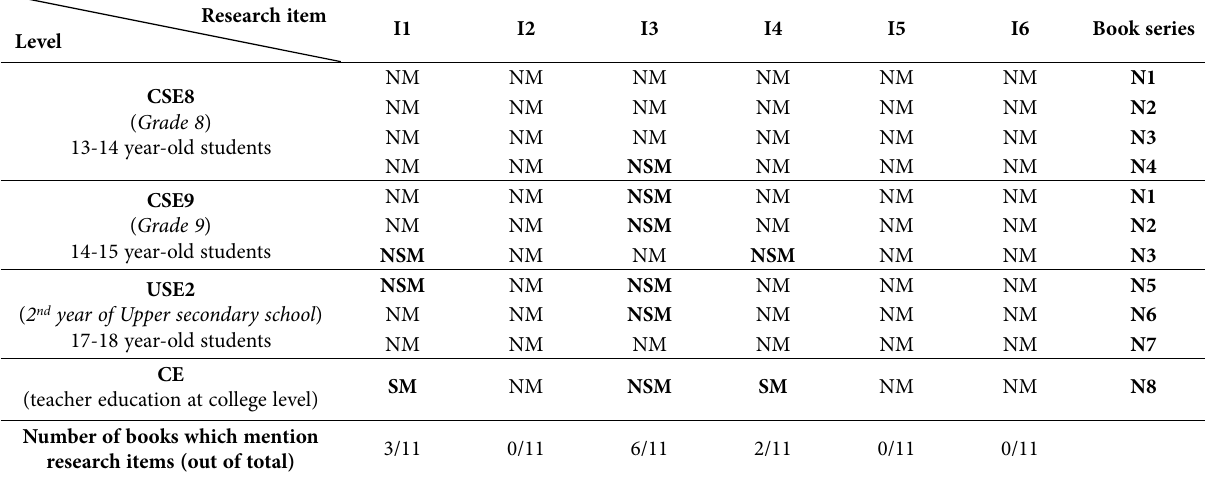
Table 6. Results from categorization of Norwegian texts on the history of the periodic system. SM, satisfactory mention; NSM, non-satisfac- tory mention; NM, no